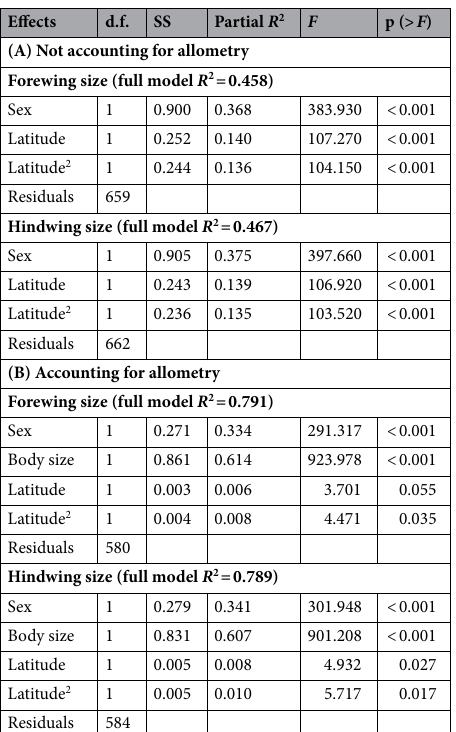
Table 1. A. Results of the General Linear Models inspecting the effects of latitude and sex on the variation of fore- and hindwing size in Lestes sponsa . B. Results of the General Linear Models inspecting the effects of latitude, body size (measured as head width) and sex on the variation of fore- and hindwing size in Lestes sponsa